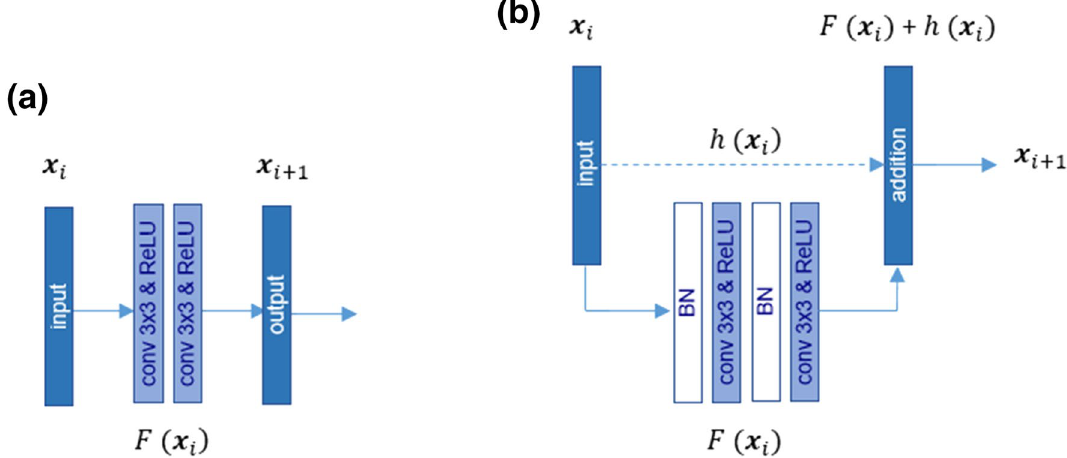
Figure 2. Illustration of the architecture of a typical convolutional network block in a U-Net ( a ) and a residual block with an identity mapping of h ( x i ) ( b areas. The f1-score is a quantitative metric that is useful to assess the balance between precision and recall (see Eqs. 3–5).